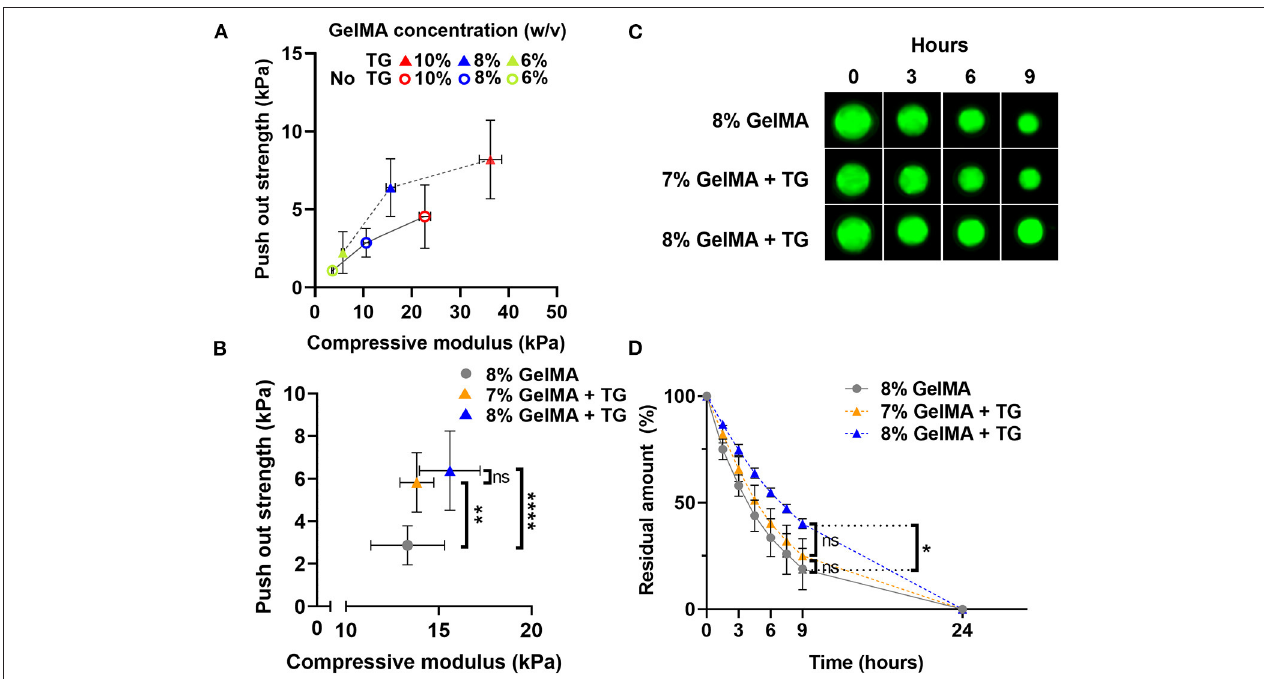
FIGURE 6 | Comparison of push out strength and enzymatic degradation performance for materials with matched stiffness (A) Scatter plot of push out strength against compressive modulus (kPa) for three GelMA concentrations with and without transglutaminase. (B) Scatter plot of push out strength against compressive modulus for 8% GelMA without and with transglutaminase, and 7% GelMA with transglutaminase. Data points represent mean and standard deviation of three samples for compression, and six or more samples for push out test. Significance was assessed via one-way ANOVA with Bonferroni post-hoc test. ** p < 0.01, **** p < 0.0001. (C) Fluorescence imaging of GelMA scaffolds at 8%, with and without transglutaminase, and 7% with transglutaminase after incubation in PBS containing collagenase type II (5 U/ml). (D) Residual amount of scaffold remaining calculated via cumulative loss of fluorescent material for GelMA scaffolds at 8%, with and without transglutaminase, and 7% with transglutaminase. Data points are the mean with standard deviation for three scaffolds for each condition. Significance was assessed using a one-way ANOVA with Bonferroni post-hoc test. * p <